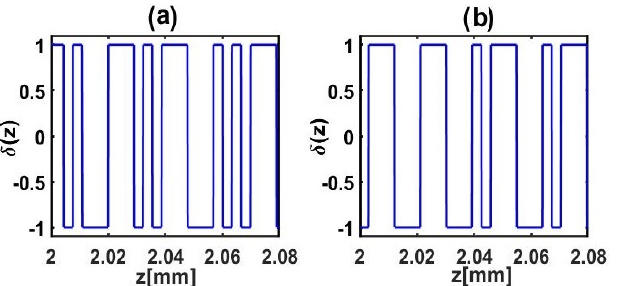
Figure 7. Examples of domain arrangements in the central portion of a QPM quadratic crystal. ( a , b ) The APP − LN cases studied in Figures 4 and 5, respectively.